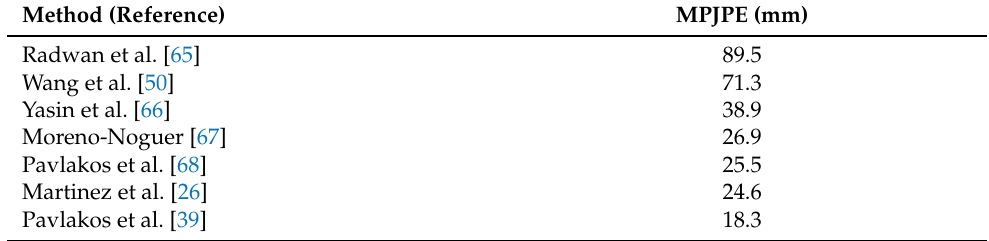
Table 3. Mean per-joint position error (MPJPE) for state-of-the-art approaches on the HumanEva- I